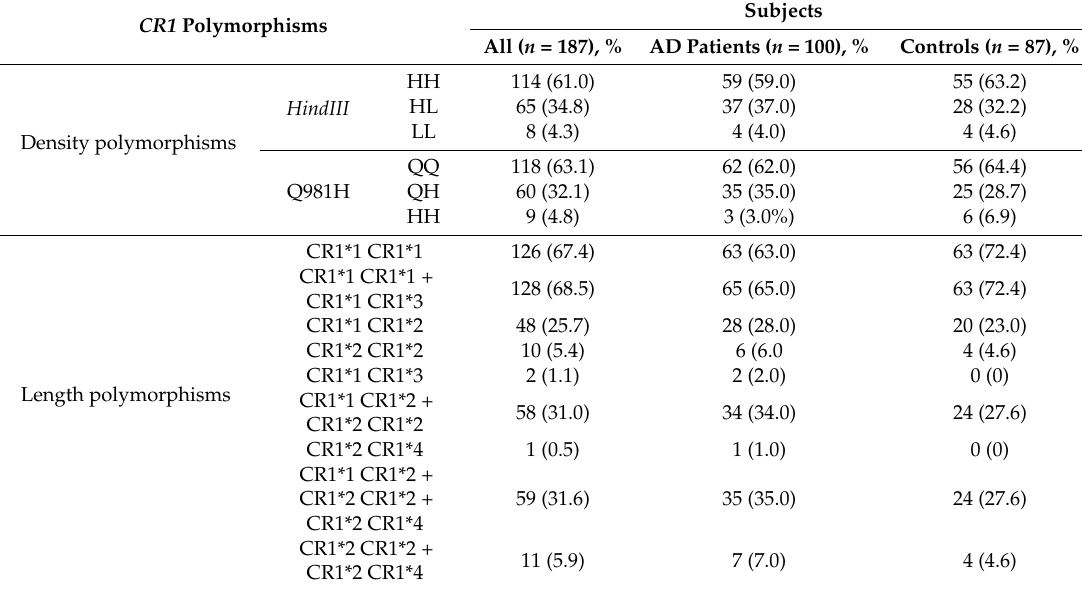
Table 2. Distribution of CR1 density and length polymorphisms among AD patients and